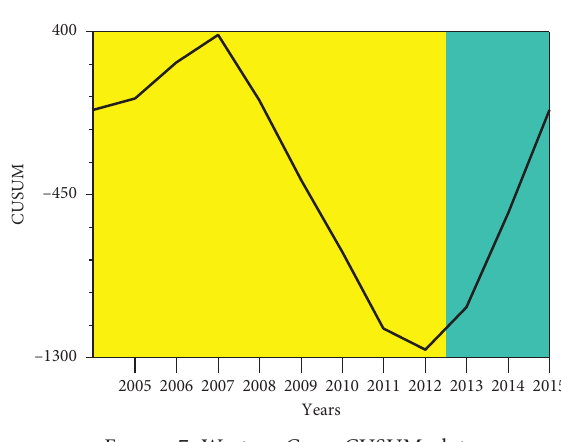
Figure 6: Western Cape background changes.